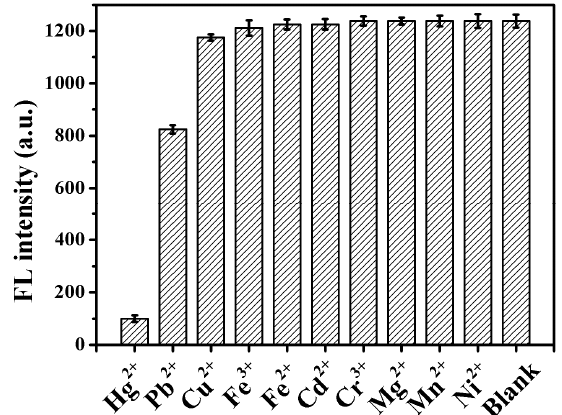
Figure 6. Selectivity of the fluorescence assay of Hg 2+ . The fluorescence intensity of TMPyP-dT 30 was attained in the absence (Blank) and presence of 4.0 μ M of Hg 2+ , Pb 2+ , Cu 2+ , Fe 3+ , Fe 2+ , Cd 2+ , Cr 3+ , Mg 2+ , Mn 2+ or Ni 2+ . The vertical bars designate the standard deviation of the mean of three replicate measurements. Table 2. Determination of Hg 2+ in water samples with the proposed